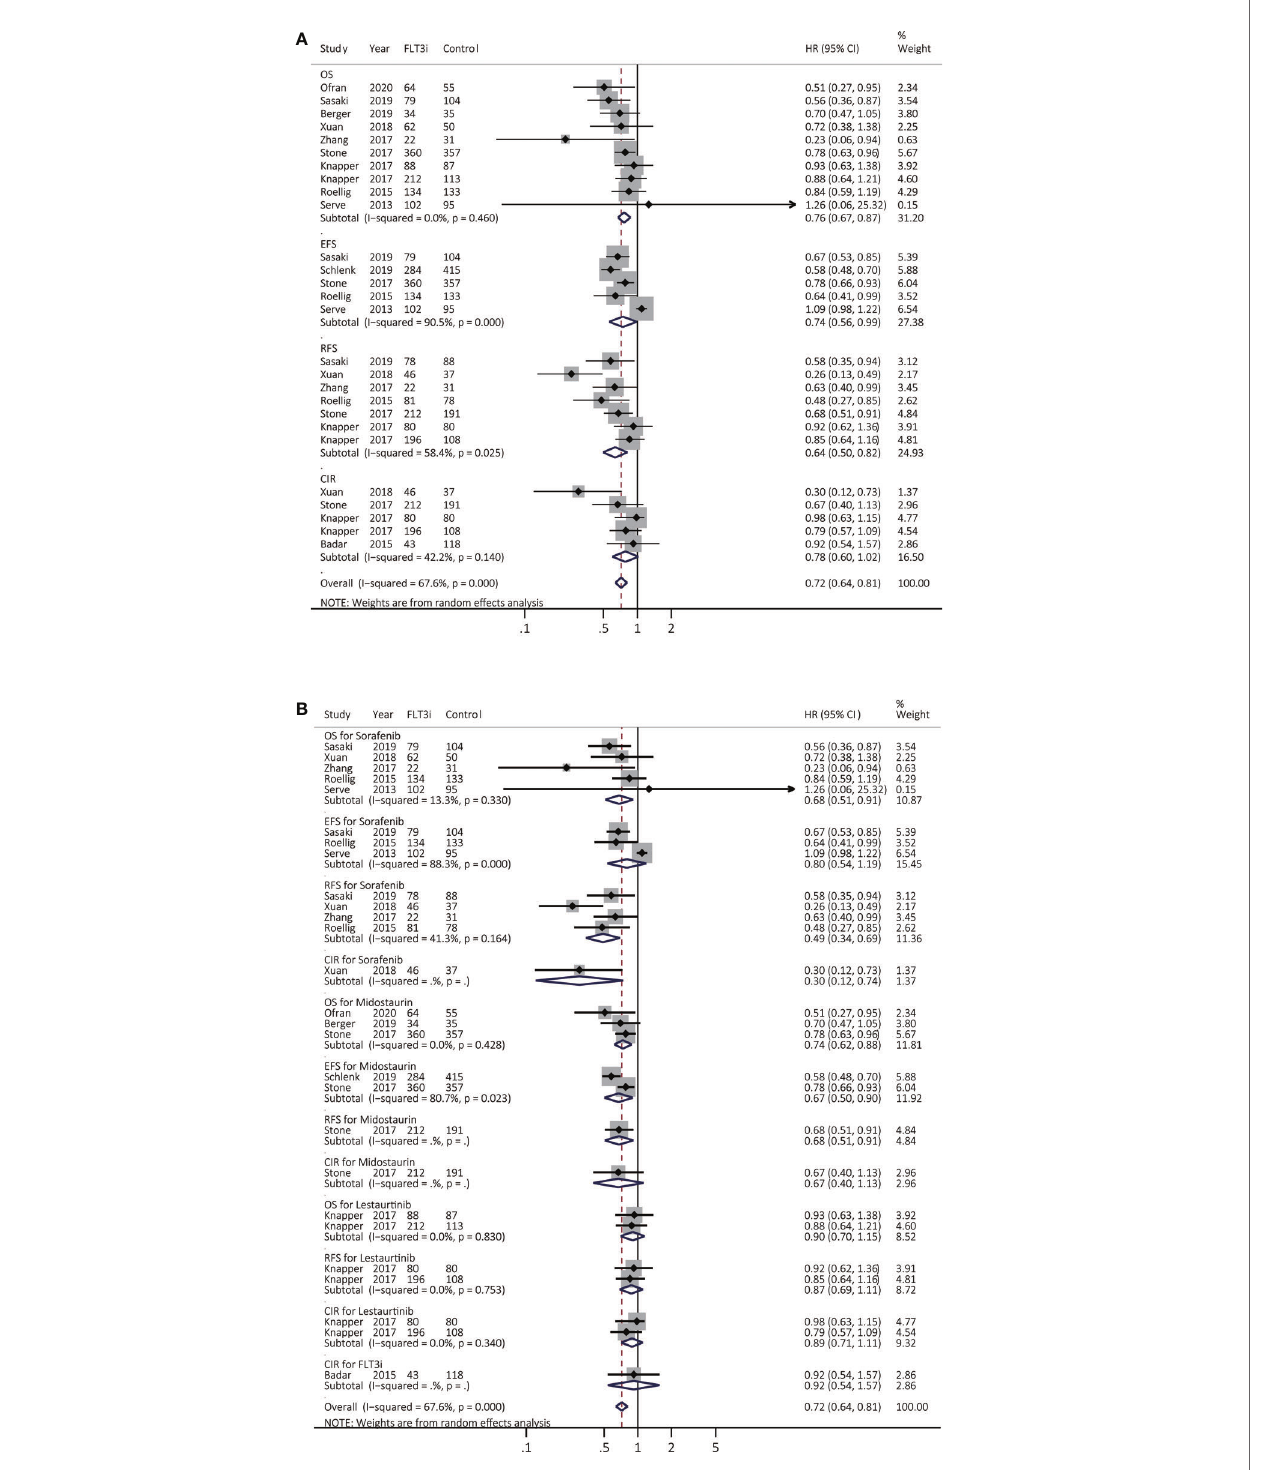
FIGURE 2 | Survival in fl uences of FLT3i on newly diagnosed AML during induction treatment. (A) Pooled HR and 95% CI of all FLT3i during induction treatment in newly diagnosed AML for OS, EFS, RFS and CIR; (B) Pooled HR and 95% CI of each FLT3i during induction treatment in newly diagnosed AML for OS, EFS, RFS and CIR. FLT3, FMS-like tyrosine kinase 3; FLT3i, FLT3 inhibitor; AML, acute myeloid leukemia; OS, overall survival; EFS, event-free survival; RFS, relapse-free survival; CIR, cumulative incidence of relapse; HR, hazard ratio; 95% CI, 95% con fi dence